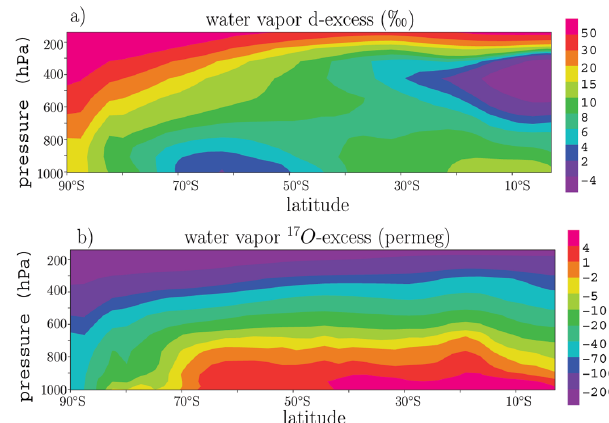
Fig. 2. Zonal mean of simulated d-excess (a) and 17 O -excess (b) in water vapor as a function of latitude and altitude in the Southern